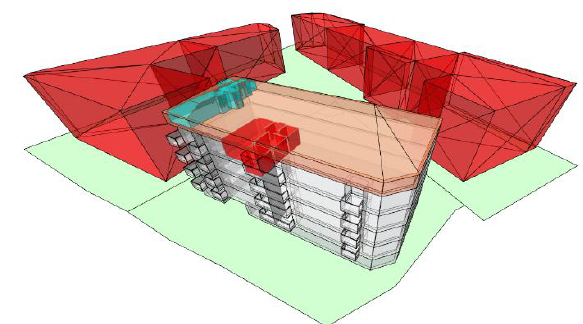
Figure 9. Part of the building modelled accordingly to Report of particular parts